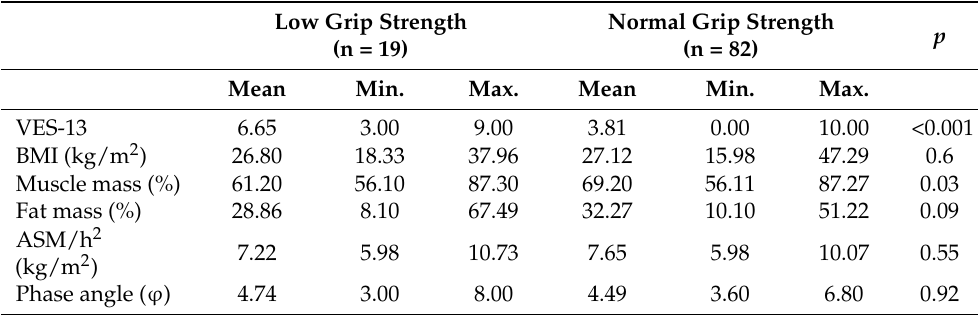
Table 5. Comparison of patients with low grip strength to patients with normal grip